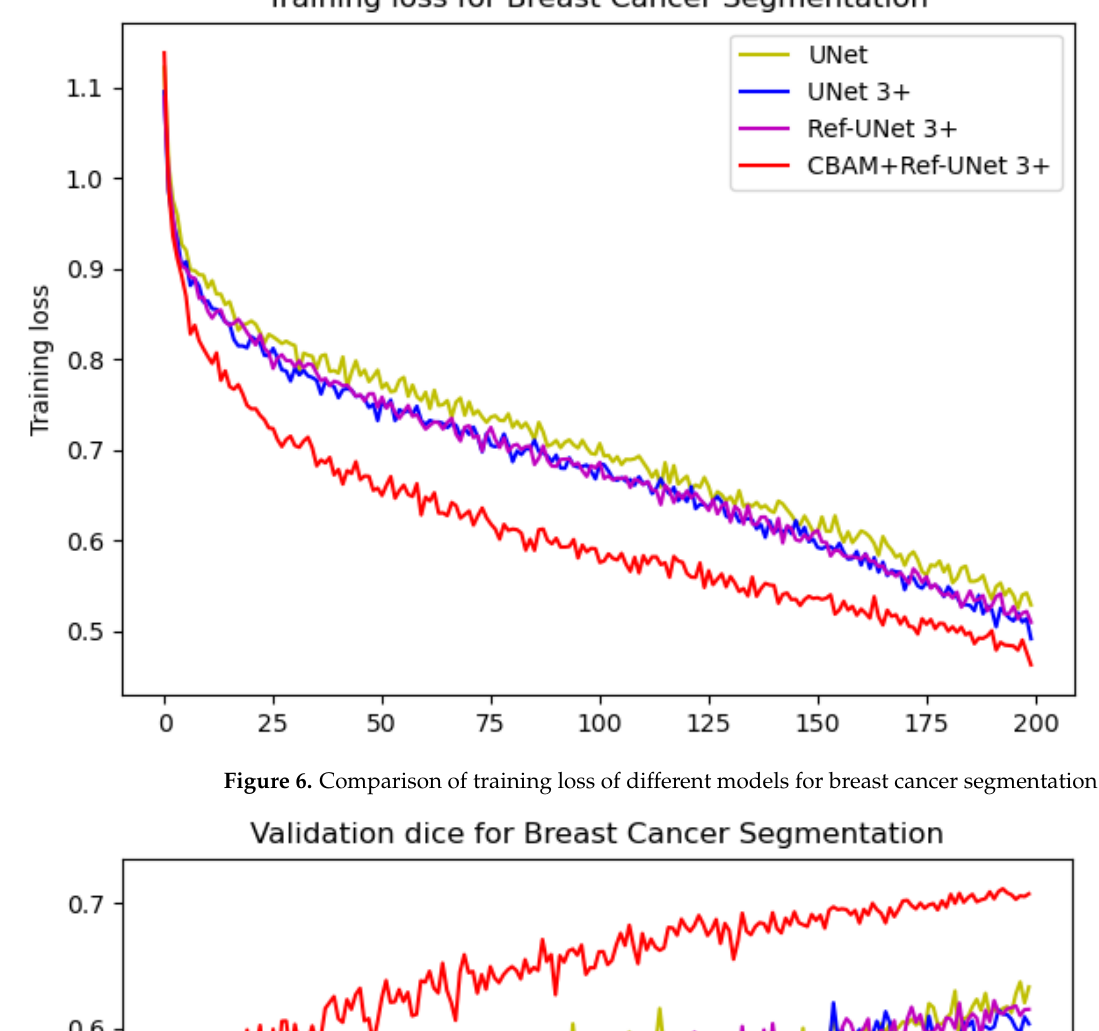
Figure 6. Comparison of training loss of different models for breast cancer segmentation.